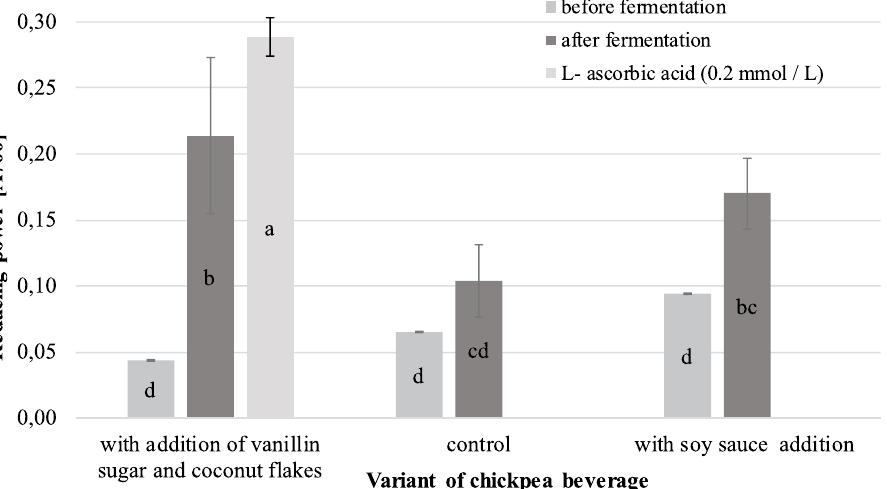
Fig. 2. Comparison of the reducing power exhibited by the analyzed chickpea beverages Explanatory notes: Mean values ± mean standard deviation (x ±s/SD; n = 3) with different letters indicate statistically significant difference